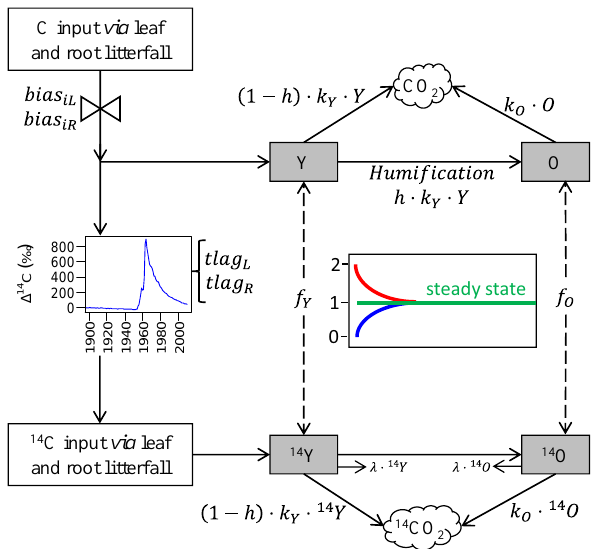
Fig. 1. Conceptual overview of the modification of the Introductory Carbon Balance Model as used in this paper. We call this model setup I 14 CBM. All parameters except for λ are calibrated. The dashed lines indicate which pools are affected by the steady-state relaxing parameters f Y and f O